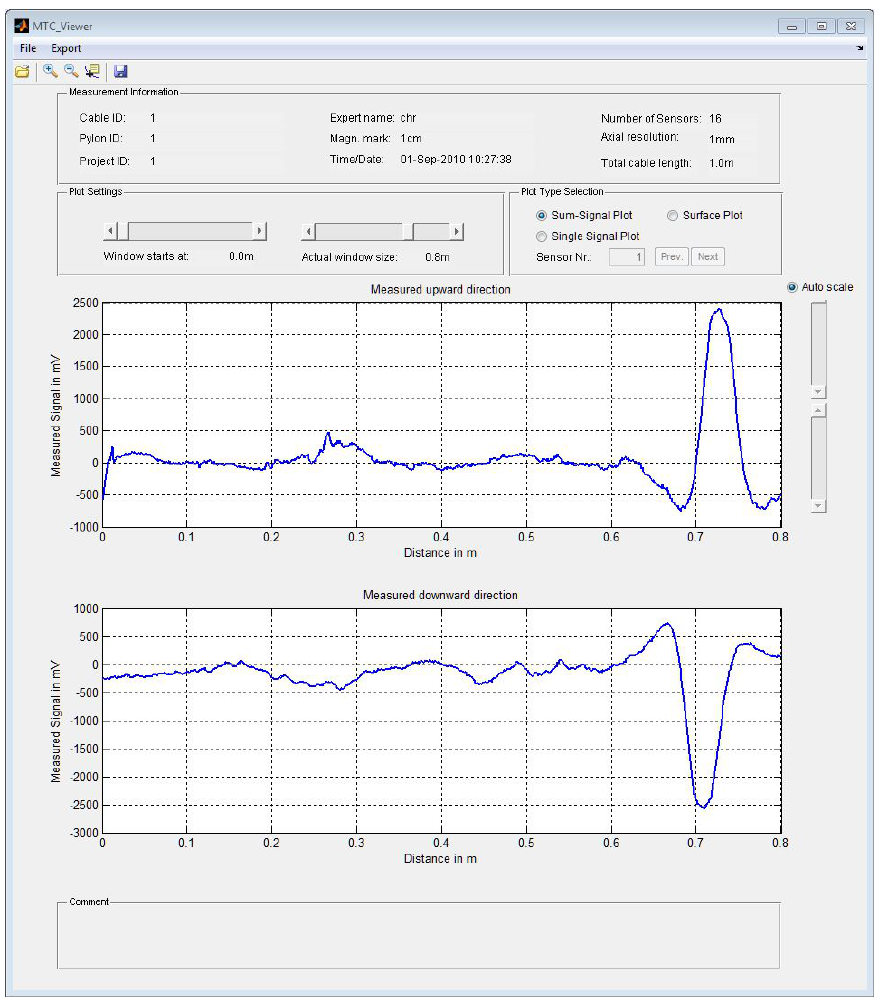
Figure 7. File header info displayed on data viewer tool together with the acquired